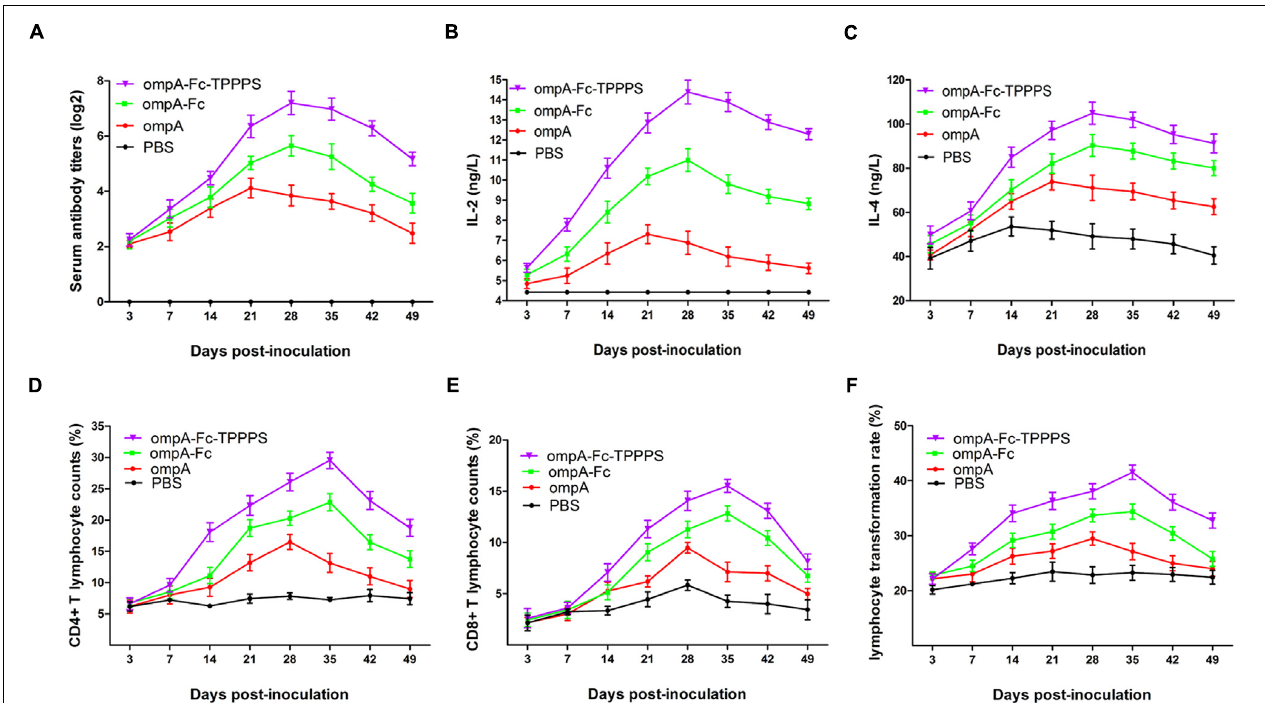
FIGURE 5 | Linked Fc and TPPPS adjuvant enhance the humoral and cell-mediated immune responses. Chickens in the four groups were, respectively, inoculated with ompA subunit vaccine, ompA–Fc subunit vaccine, TPPPS adjuvant ompA–Fc subunit vaccine, and PBS at 0, 7, and 14 dpv. The specific anti-ompA antibody titers (A) were determined by indirect ELISA as previously described, and the concentrations of IL-2 (B) and IL-4 (C) were determined by commercial ELISA kits; the percentages of CD4 + (D) and CD8 + (E) T lymphocytes and LTRs (F) were detected by flow cytometry and MTT assay, respectively. All values represent the means ± SD of three independent experiments.